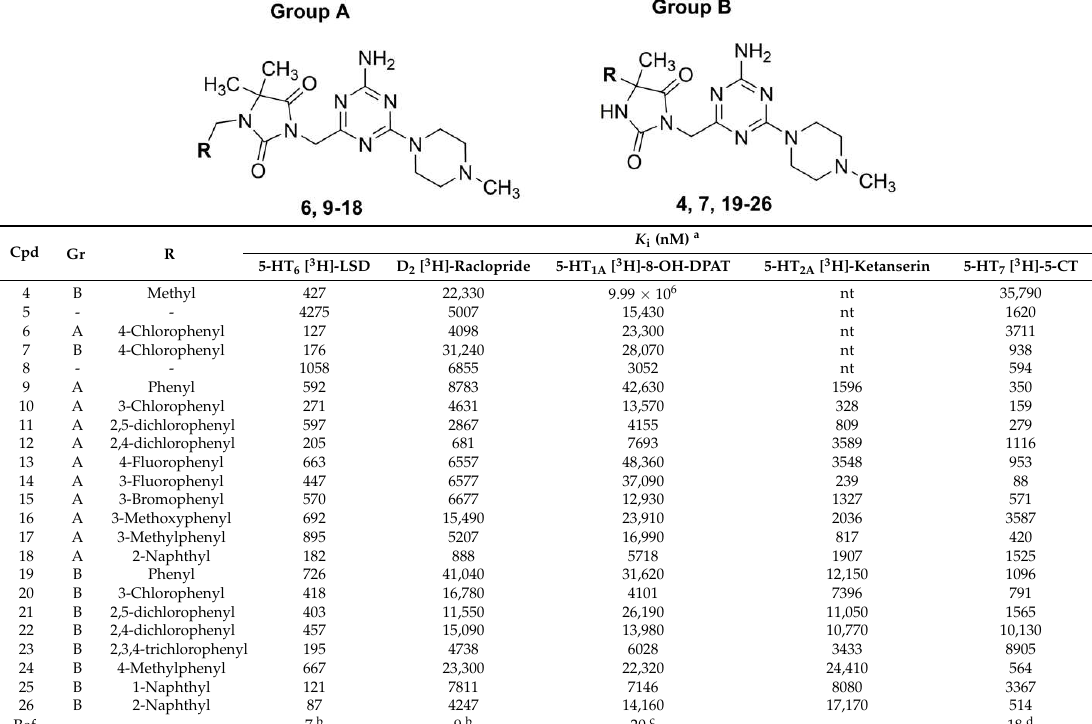
Table 1. Structures and affinities for serotonin/dopamine receptors of hydantoin-triazine compounds 4 – 26 .